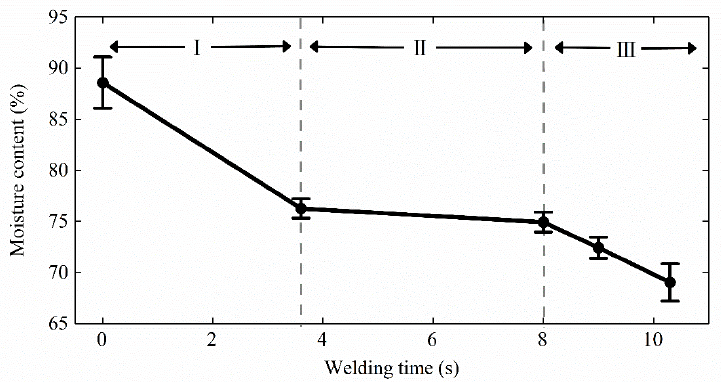
Figure 10. Moisture content during welding under the compression pressure of 205 kPa. The moisture evaporates intensely in Periods Ⅰ and Ⅲ but remained almost unchanged in Period Ⅱ . Water would be evaporated in the latter half of Period Ⅰ , increasing the tissue impedance. The impedance increased rapidly in Period Ⅲ , owing to the reduced moisture content weakening the conductivity. Sensors 2022 , 22 , x FOR PEER REVIEW